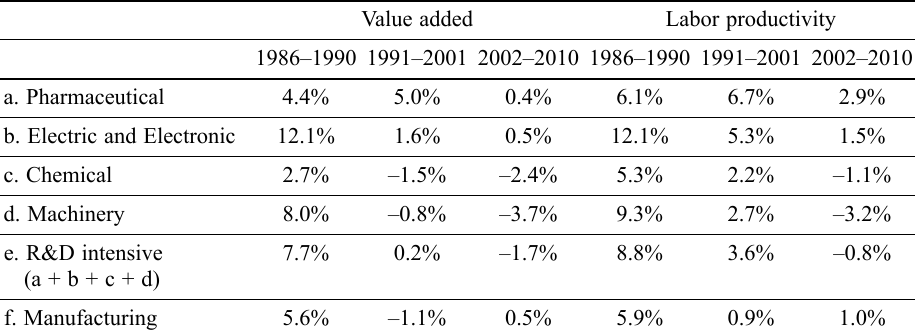
Table 1. Average annual growth of real value added and labor productivity by industry Value